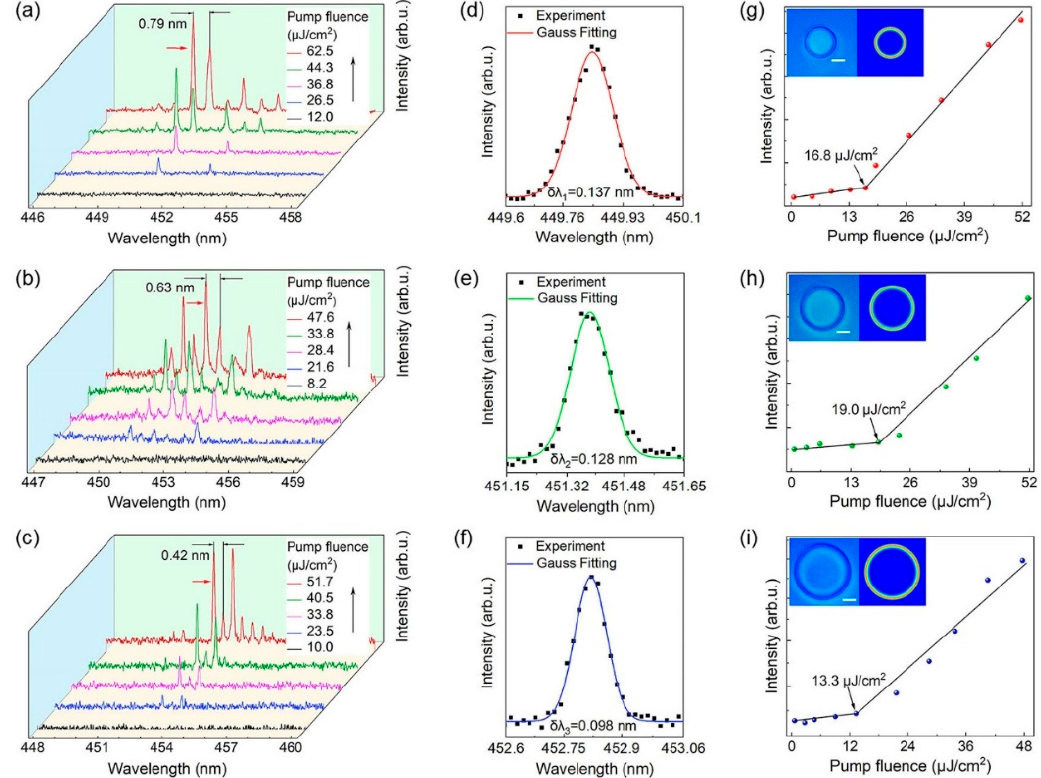
Figure 2. Laser characteristics of the PFO microring lasers. ( a – c ) The normalized photoluminescence spectra of microrings at different pump fluences, and the diameters are 53, 67, and 85 µ m, respectively. ( d – f ) Gaussian fitting of the lasing oscillation mode. ( g – i ) Plots of the PL peak intensities versus pump fluence for microrings with diameters of 53, 67, and 85 µ m, respectively. Left inset: microscope image of the microrings. The scale bar is 20 µ m. Right inset: simulated electric field intensity distribution of the microring resonators.